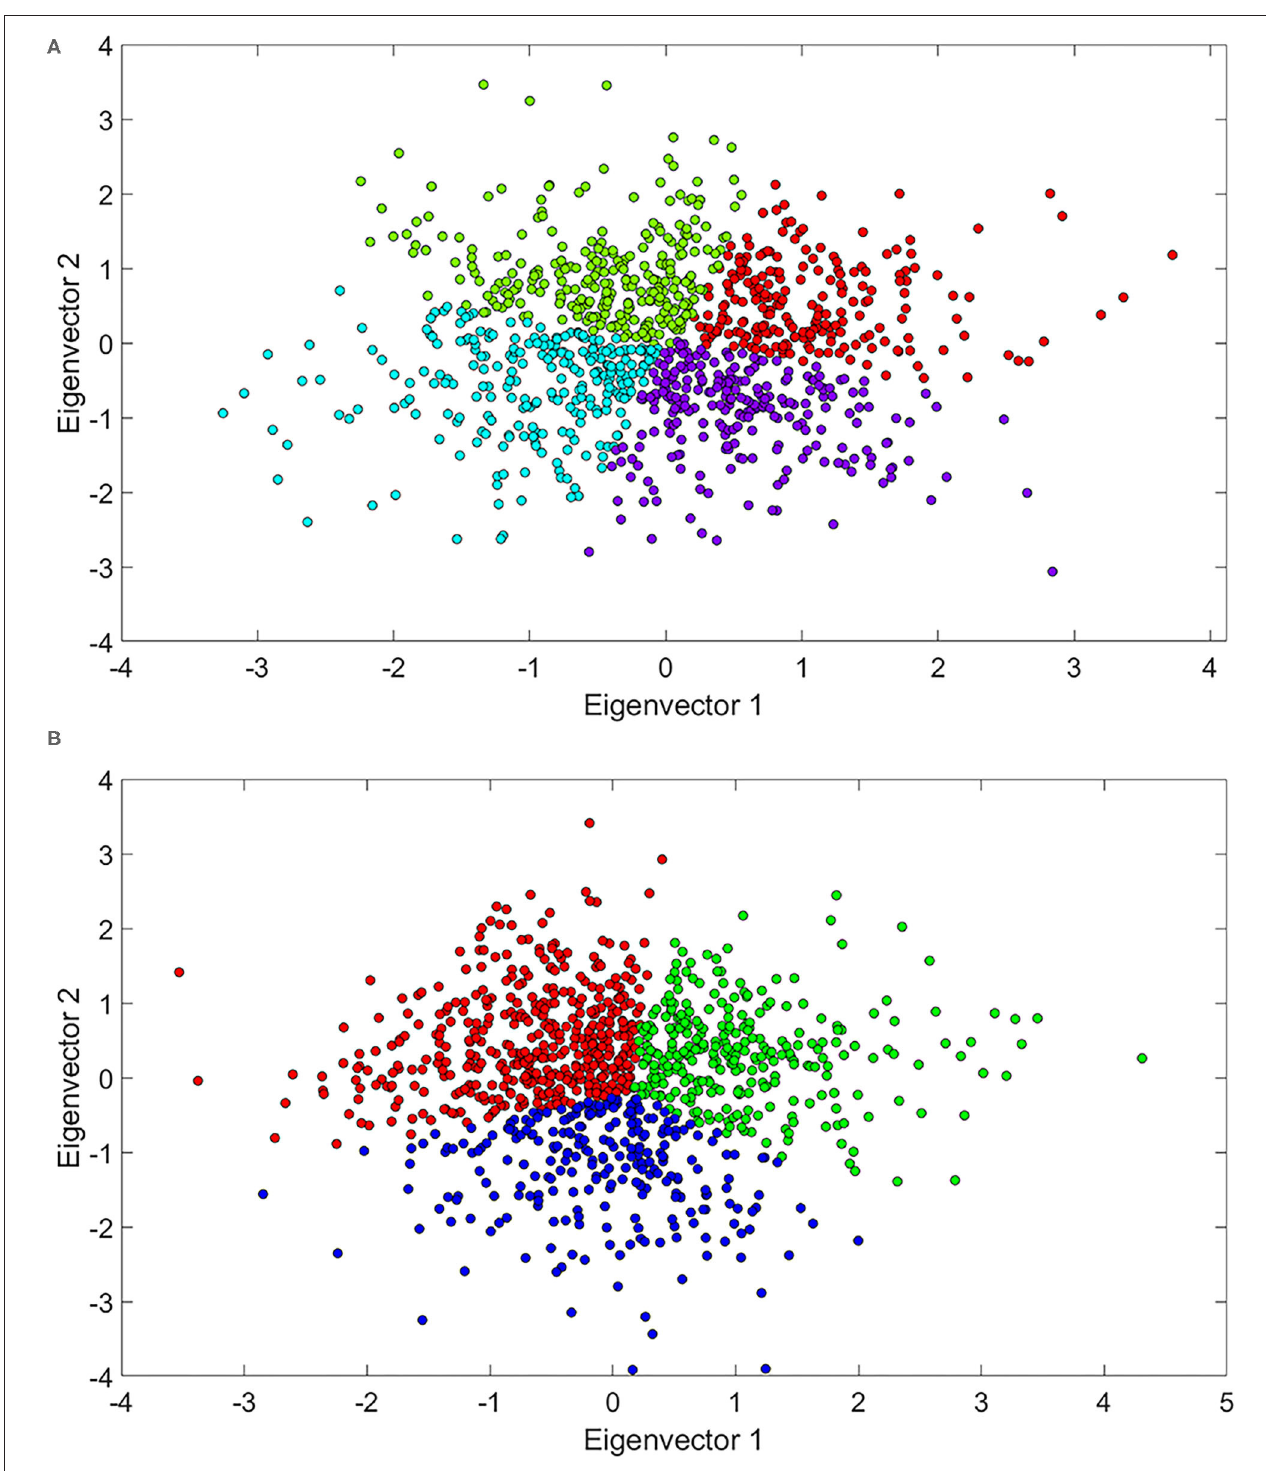
FIGURE 8 | PCA representation, based on the modulation of ADHD effectors, of LDX and MPH mechanisms of action in (A) ADHD adult patients and (B) ADHD children-adolescent patients. ADHD, Attention-deficit/hyperactivity disorder; LDX, Lisdexamfetamine; MPH, Methylphenidate; PCA, Principal component analysis.